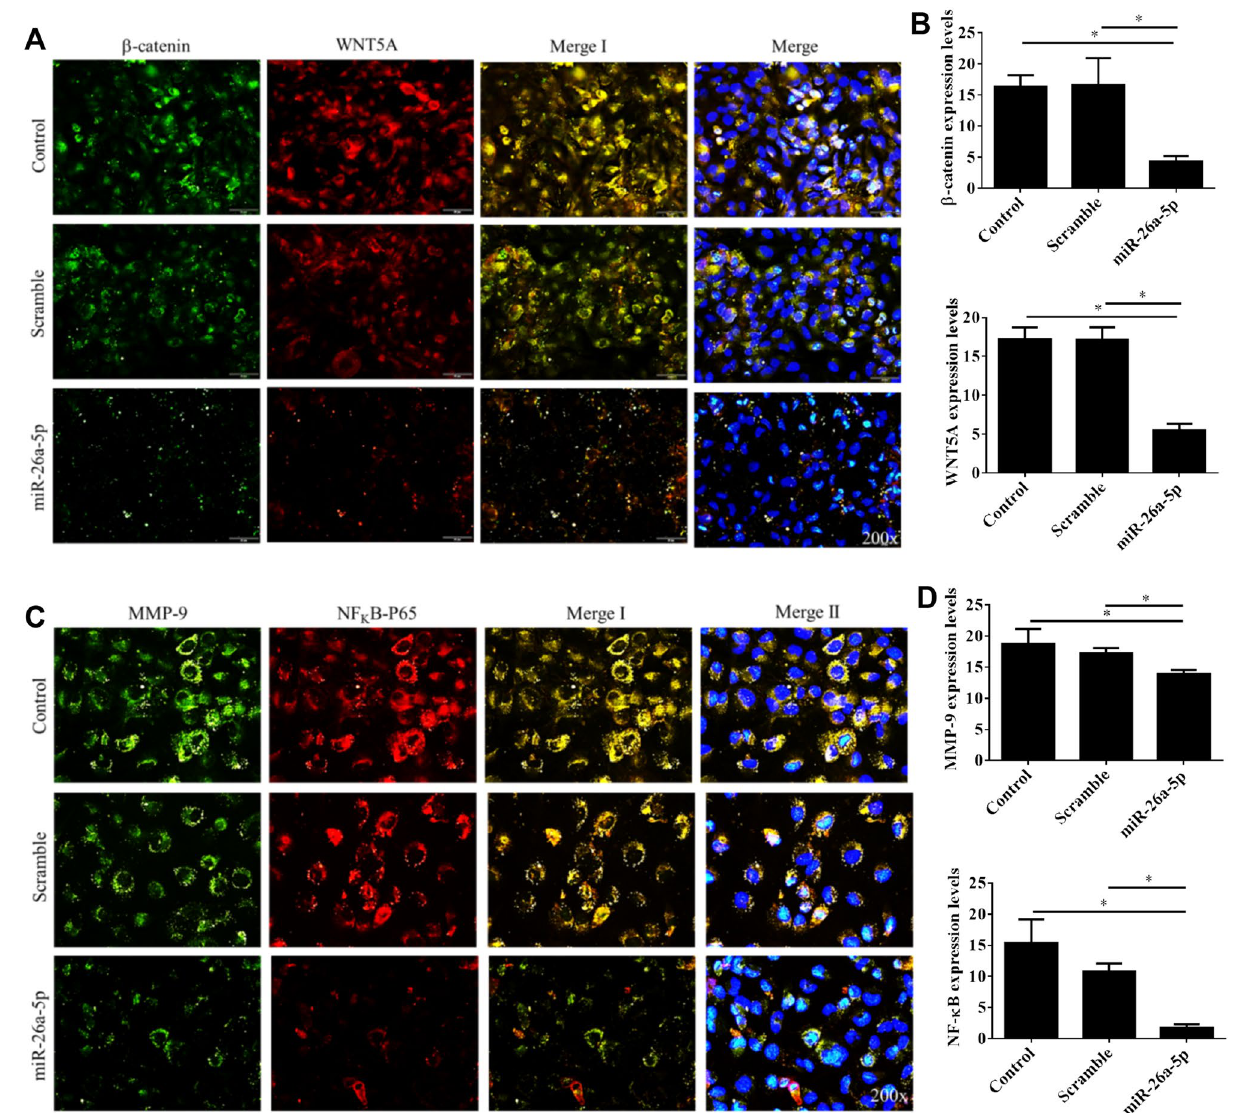
Figure 5. WNT5A/β-catenin signaling and downstream molecules were inhibited by the miR-26a-5p overexpression in UTUC cells. BFTC-909 cells were transfected with miR-26a-5p mimics for 48 h and subjected to immunofluorescent staining. Representative images for cellular distributions of ( A ) β-catenin (green), WNT5A (red), and nuclei (blue) were shown. ( C ) Alternatively, cellular distributions of MMP-9 (green), NF-κB p65 (red), and nuclei (blue) were immunofluorescently visualized. The fluorescence intensities of β-catenin and WNT5A ( B ), MMP-9 and NF-κB ( D ) were quantified by counting 5–10 different fields per sample. Data are expressed as mean ± SEM (n = 3). *Indicates a P < 0.05 between the indicated groups. Original magnification: ×